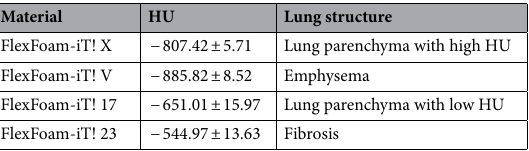
Table 2. Lung structures matched with the HU of the FlexFoam-iT. HU, Hounsfield unit.